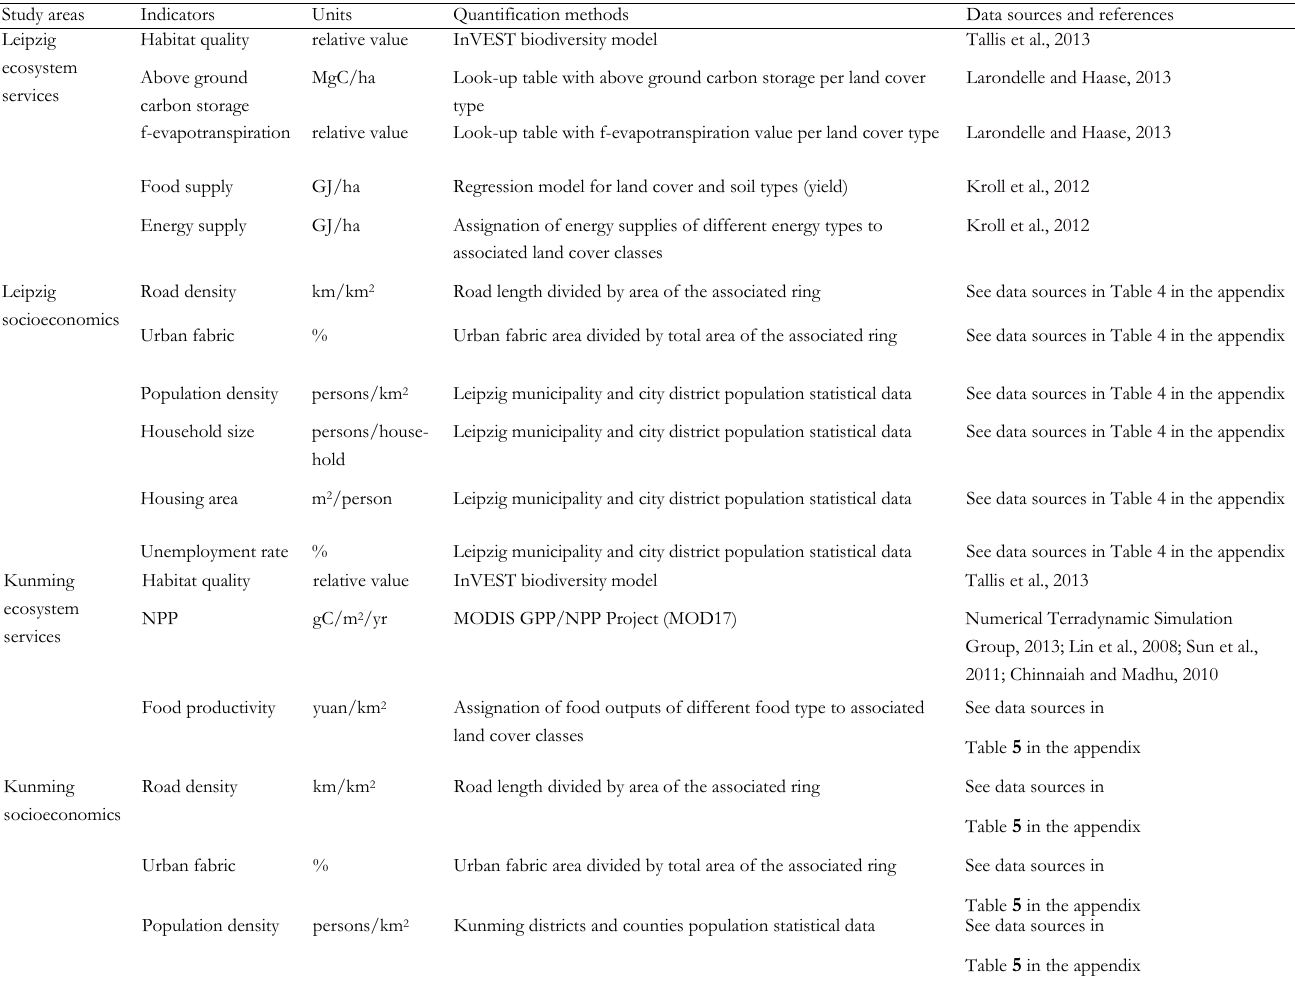
Table 1: Overview of the quantified ecosystem service and socioeconomic indicators and the calculation methods Study areas